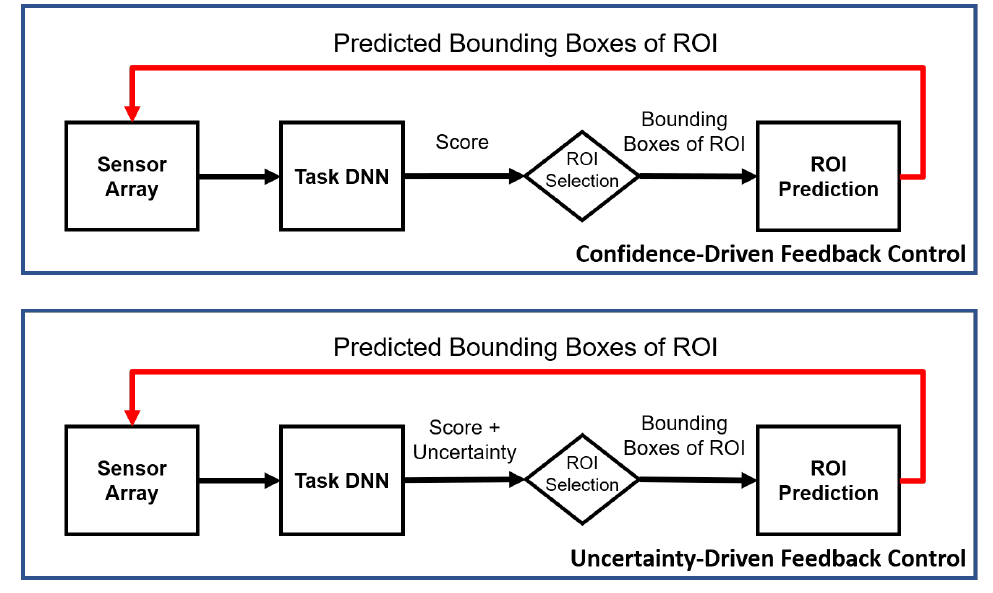
Figure 2. Proposed feedback system with uncertainty as an additional criteria for applying